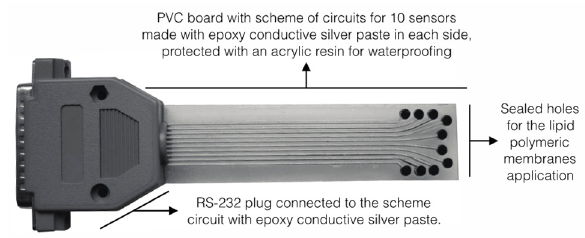
Figure 1. Sensor schematics of the electronic tongue.